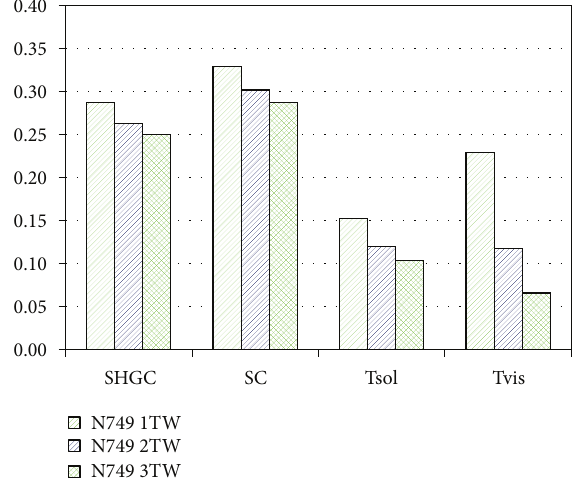
Figure 10: Thermal performance and optical performance for N749 types of DSC